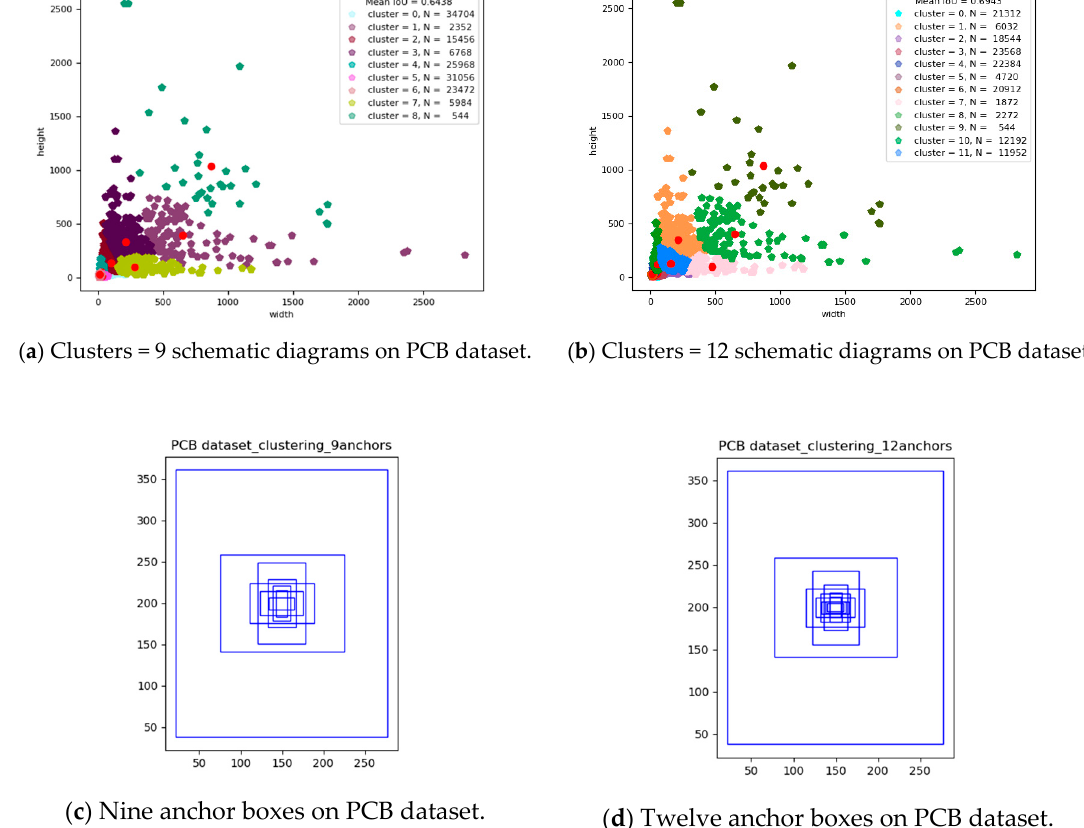
Figure 7. K-means++ clustering and generating anchor. Figure 7. K-means ++ clustering and generating